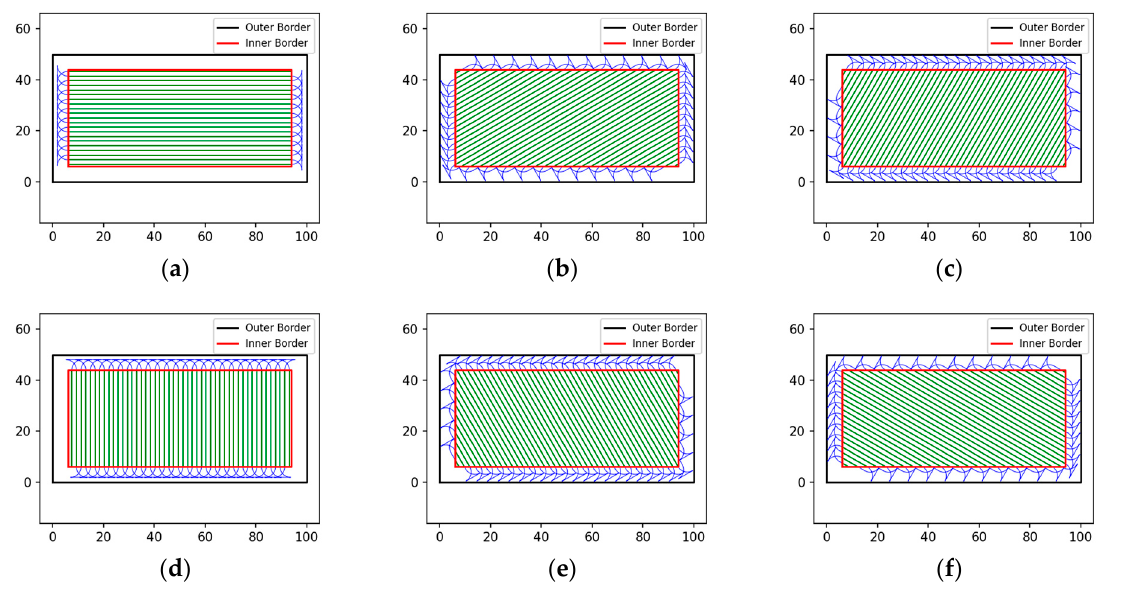
Figure 9. X- type turning patterns for the different travel directions in Figure 8: ( a ) X-type pattern with direction angle 0 ◦ ; ( b ) X-type pattern with direction angle 30 ◦ ; ( c ) X-type pattern with direction angle 60 ◦ ; ( d ) X-type pattern with direction angle 90 ◦ ; ( e ) X-type pattern with direction angle 120 ◦ ; ( f ) X-type pattern with direction angle 150 ◦ .